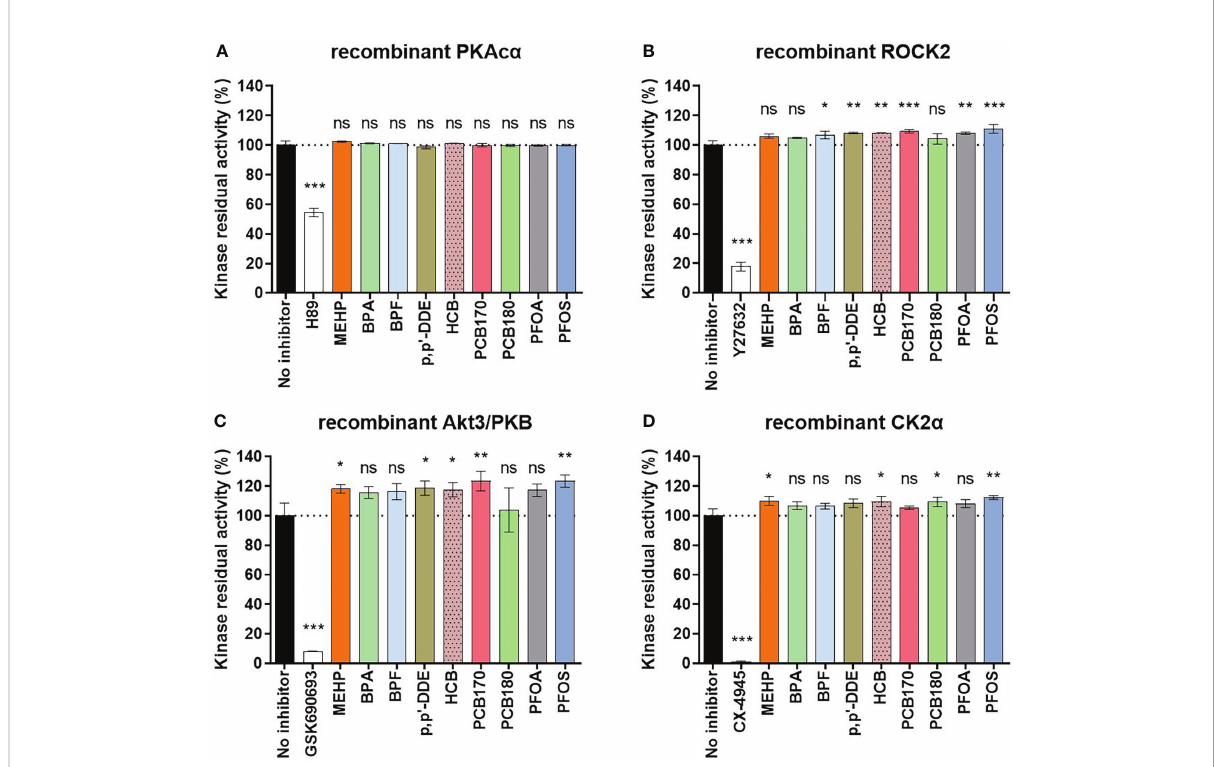
FIGURE 3 Effect of EDCs (1 m M) and selective control inhibitors (1 m M) on activities of recombinant protein kinases to assess whether EDCs have a direct effect on the protein kinases. Recombinant protein kinases (A) full-length PKAc a ; (B) His 6 -ROCK2 (amino acids 11-552); (C) His 6 -Akt3 (S472D mutant, amino acids 117-end); (D) CK2 a (amino acids 1-335) were used. The graph shows the averaged data of the three measurements as mean ± SEM (n = 2 for each kinase, performed in duplicates). Signi fi cance is calculated by one-way ANOVA with Dunnett test for multiple comparisons (95% CI) relative to no inhibitor and indicated as *P<0.05; **P<0.01 ***P<0.001 and ns, not signi fi cant. The dotted line corresponds to